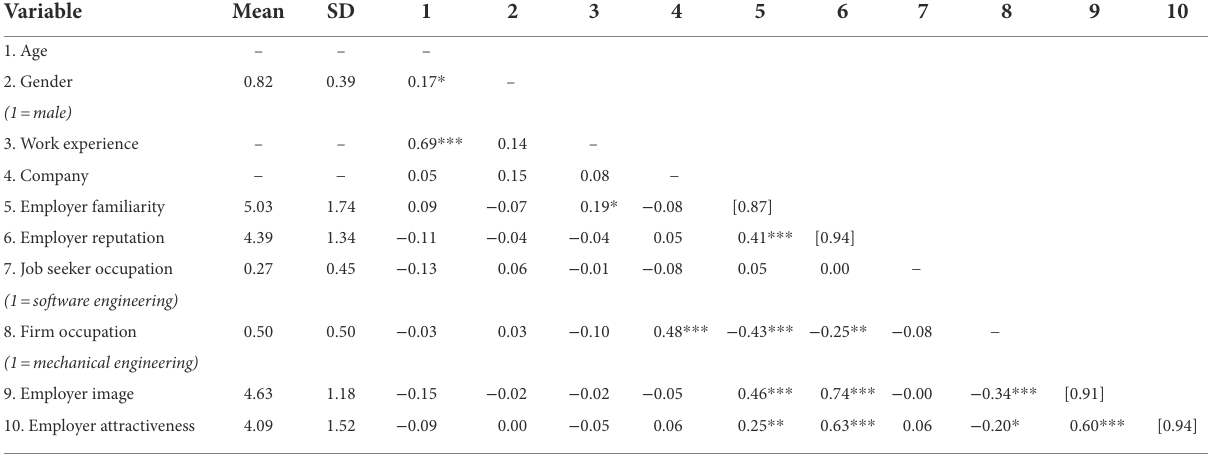
TABLE 2 Variable description, correlations, and scale reliabilities.